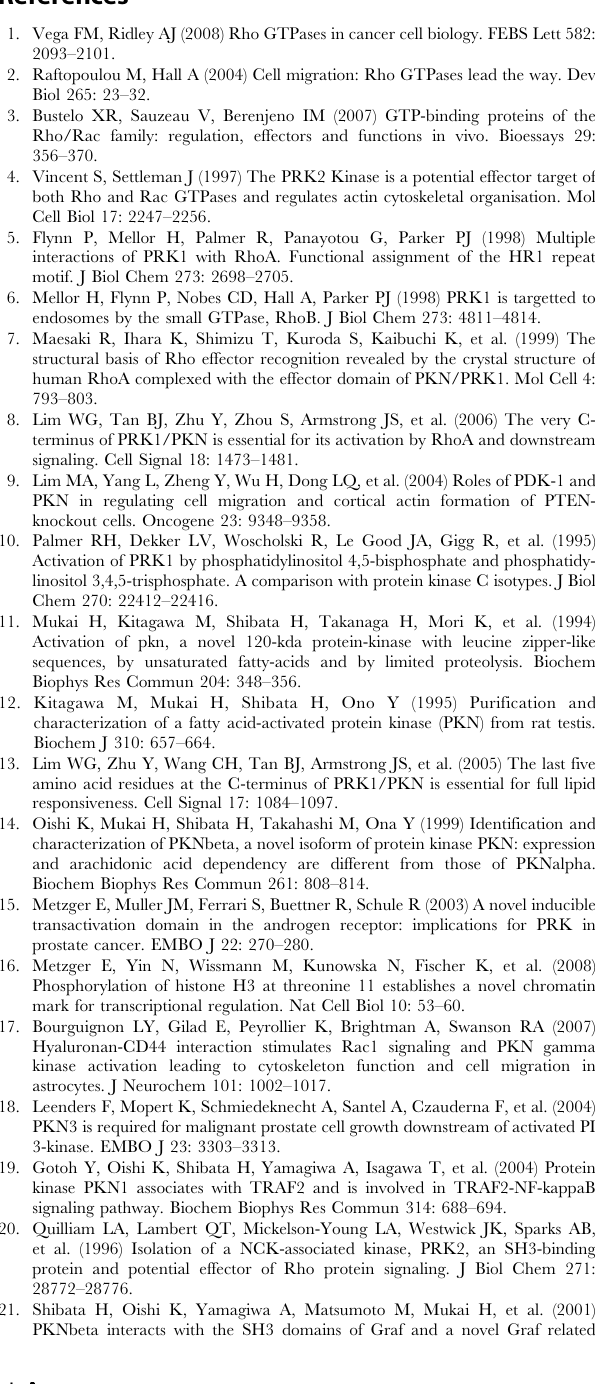
Figure S2 Knock-down of PKN1-3 inhibits invasion of MDA-MB-468 cells. A. MDA-MB-468 cells were transfected with siRNA against PKN1/2/3. 48 h post transfection cells were counted and 20 000 cells were seeded into BD invasion